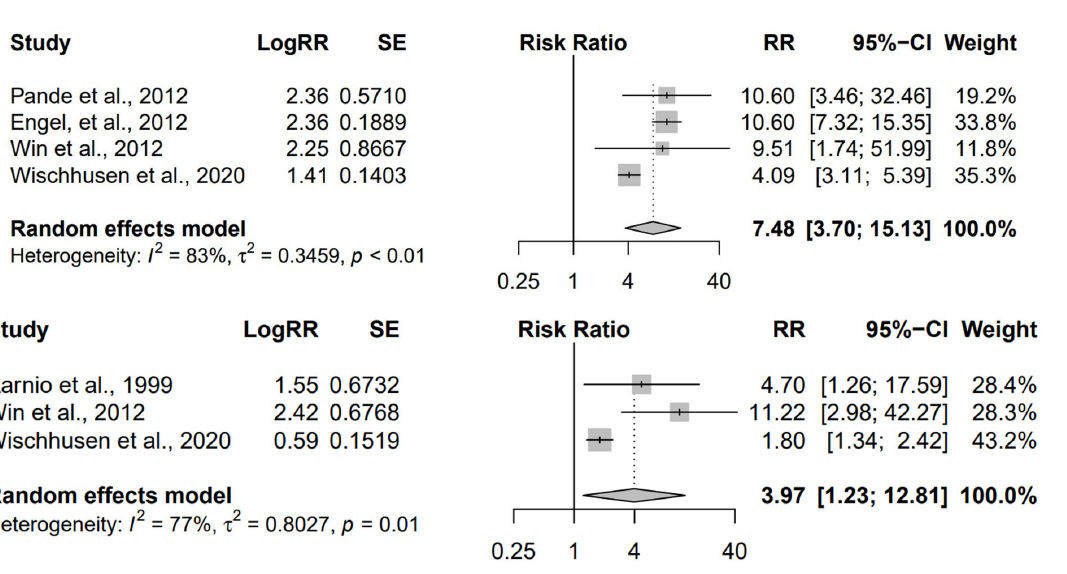
Figure 2. Meta ‐ analysis [4,22–25]. Figure 2. Meta-analysis